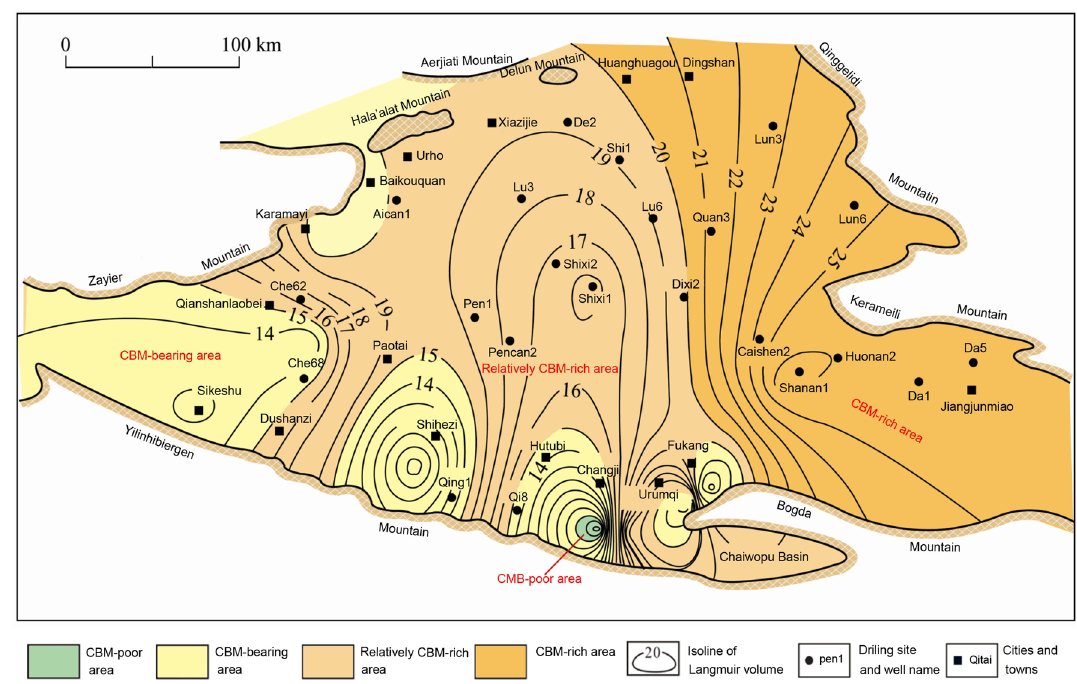
Fig. 7 Isogram of Langmuir volume distribution in the J